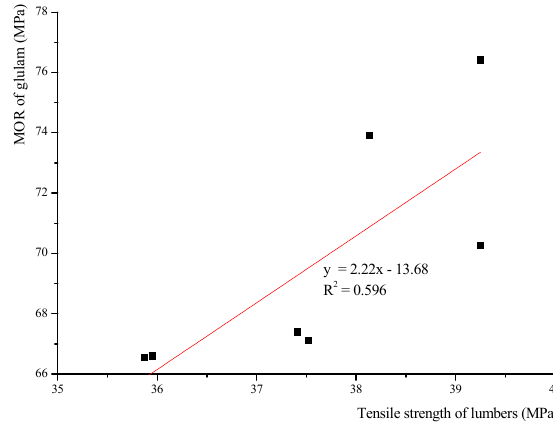
Figure 8. Linear regression analysis of the MOR of glulam.